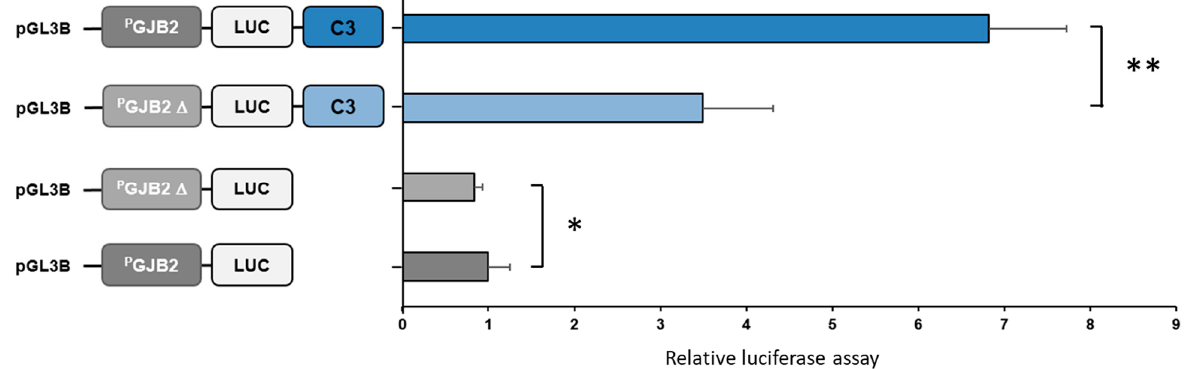
Figure 8. Functional assays of GJB2 promoter variant. Luciferase reporter constructs with the GJB2 WT promoter (P GJB2 ; 1043 bp), GJB2 mutated promoter (P GJB2 ∆ ; 1043 bp), and constructions with C3 enhancer were transfected in SAEC cells. * p < 0.05; ** p < 1.33 × 10 − 7 using analysis of variance and t -tests.